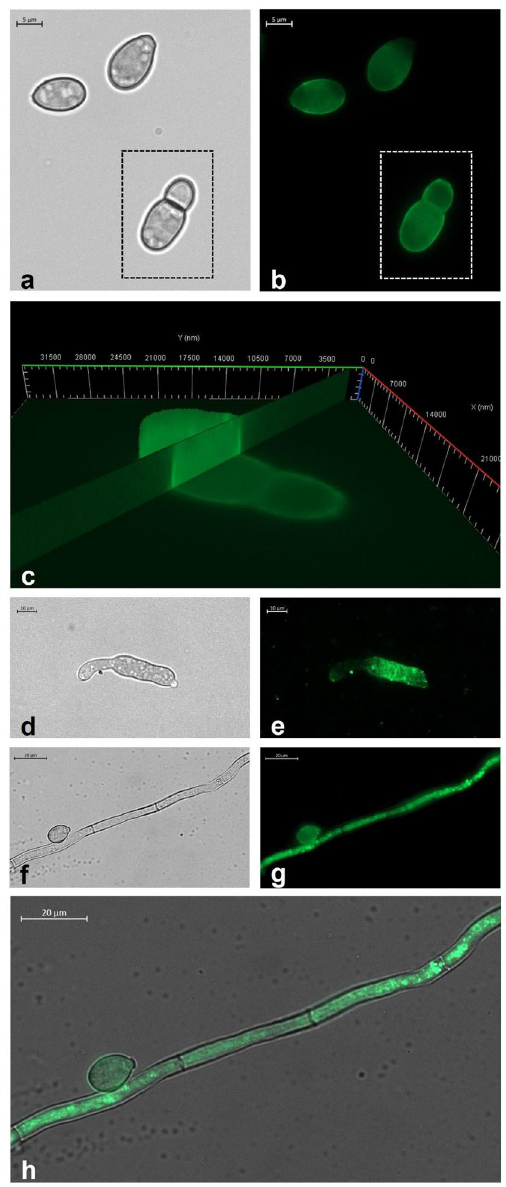
Figure 3. ( a ) Bright field and ( b ) fluorescence image of B. cinerea conidia treated for 10 min with Cu6-PLGA NPs. NPs fluorescence signal was evident in germinated B. cinerea conidia (white square) and non-germinated ones. ( c ) 3D reconstruction of B. cinerea conidia treated with NPs for 10 min. The fluorescence signal was detected inside conidia, along the whole thickness of the spore. ( d ) Bright field and ( e ) fluorescence image of B. cinerea germ tube. The NPs fluorescence signal was well visible in the expanding germ tube after 10 min of administration. ( f ) Bright field and ( g ) fluorescence image of B. cinerea conidium and hypha. The fluorescence signal was well visible both in the conidium and the hypha after 1 h of administration. ( h ) Overlap of the bright field image and the fluorescence image which shows the localization of Cu6-PLGA NPs inside the fungal conidium and